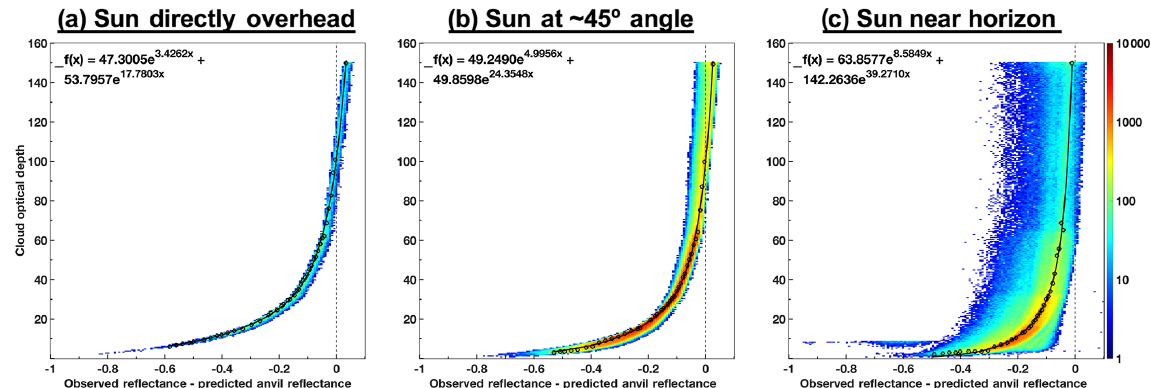
Figure 9. Cloud optical depth as a function of SatCORPS Obs − BRDF based on July 2018 CONUS retrievals for SZA ranges of (a) 0 to 3 ◦ , (b) 45 to 48 ◦ , and (c) 78 to 81 ◦